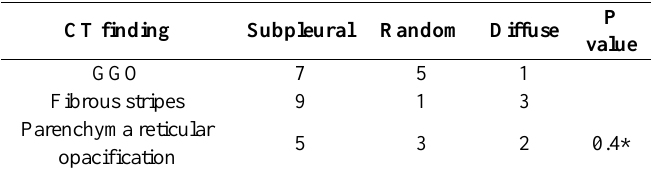
Table 4: Distribution of residual CT scan findings according to their